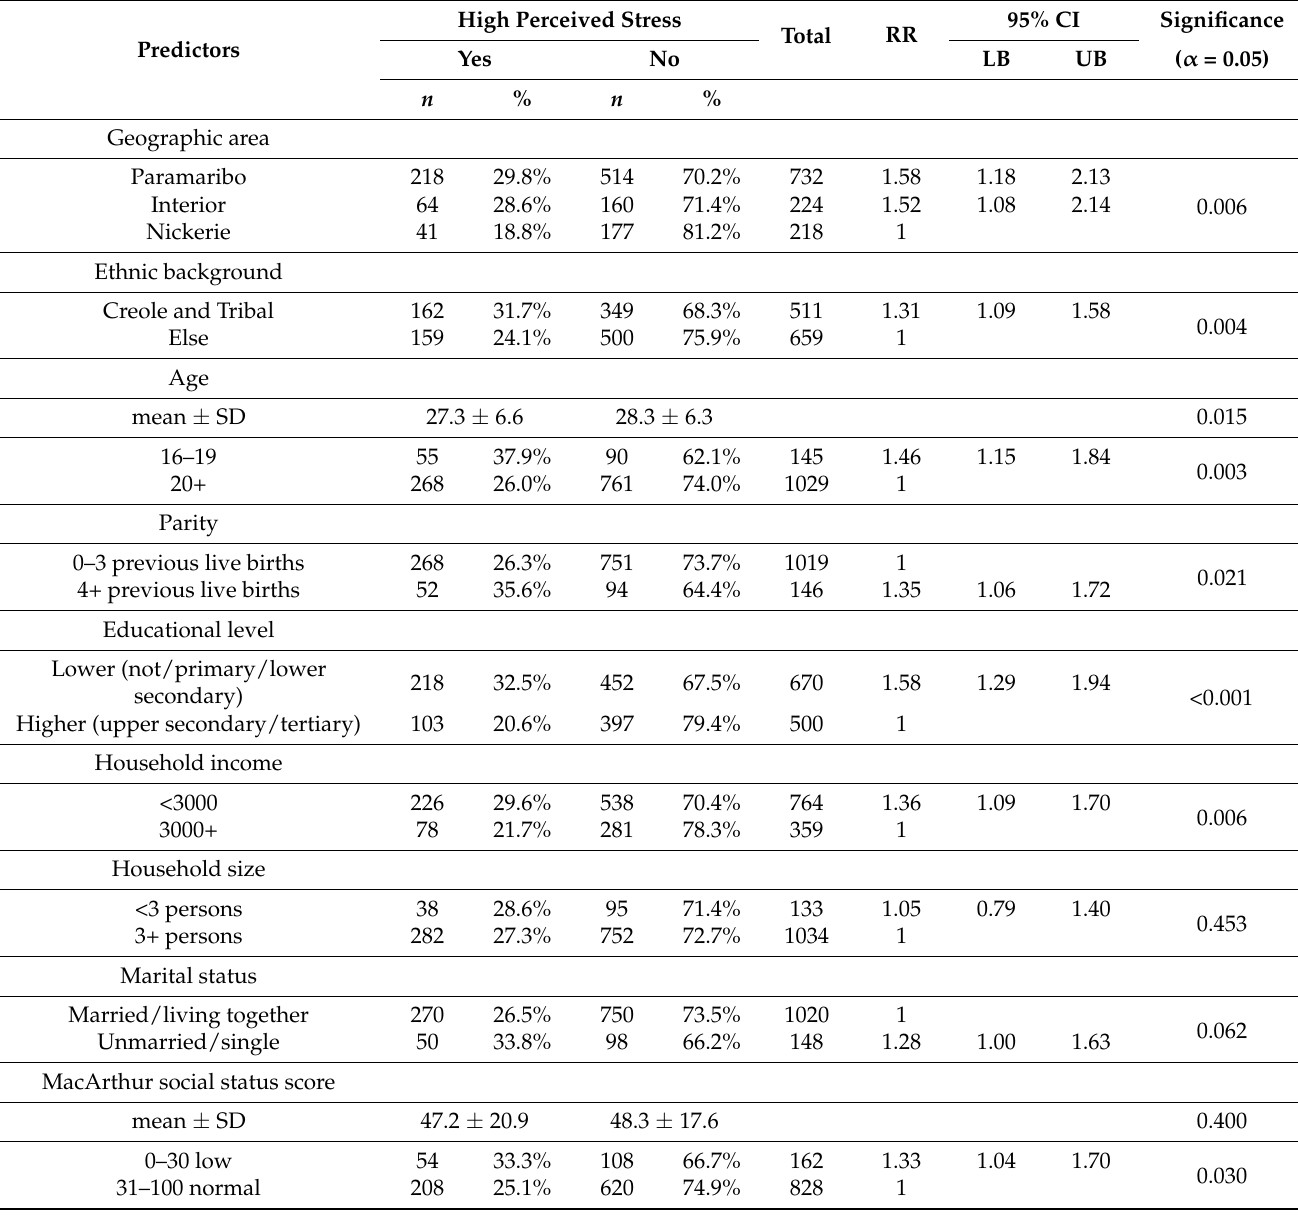
Table 2. Risk ratios (RR) with 95% confidence intervals (CI) for high perceived stress ( n =